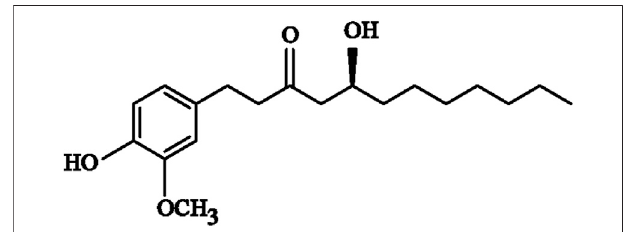
FIGURE 1 | Molecular structural formula of 8-gingerol